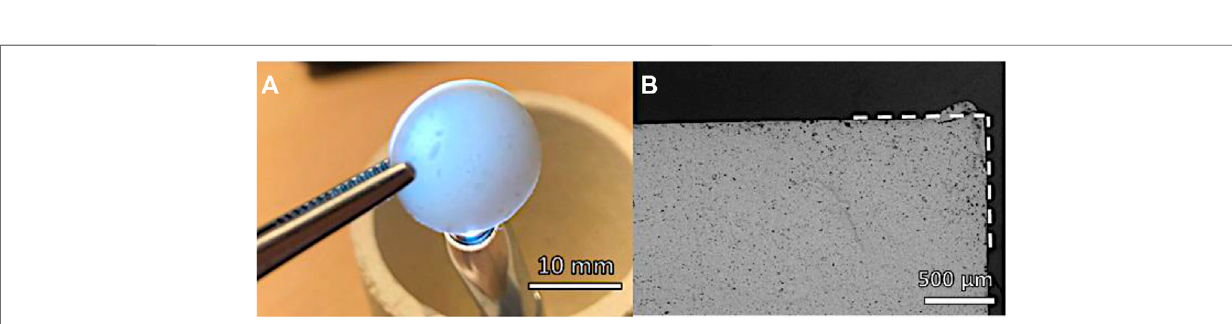
FIGURE 3 | Morphology of pellet from sintering of as received Biosilicate ®